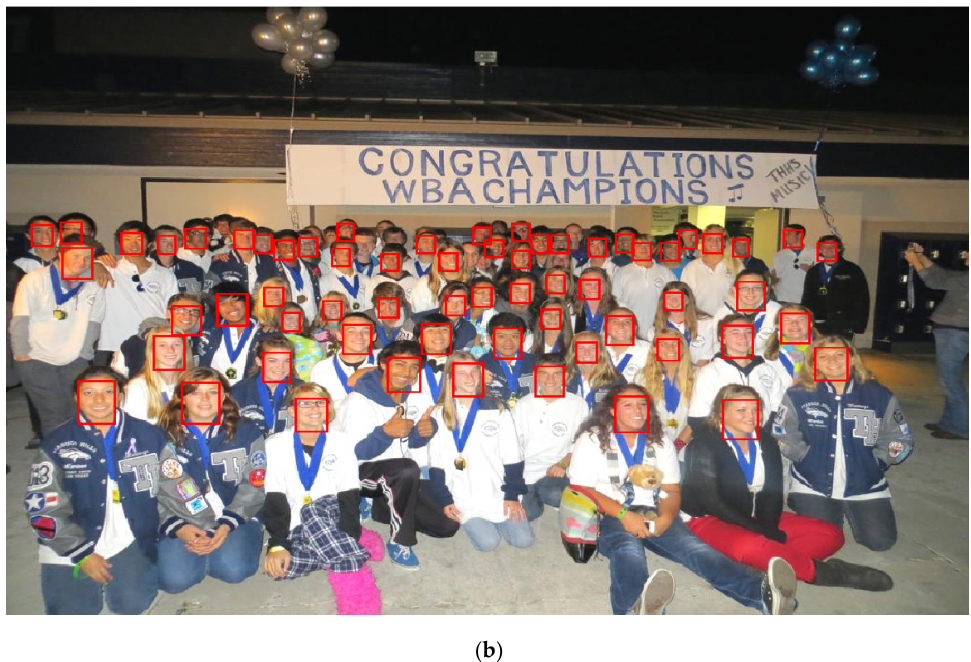
Figure 7. Detection effect of R-FCN ( a ) and f-R-FCN ( b ). ( a ) The faces detected by R-FCN. ( b ) The faces detected by f-R-FCN.